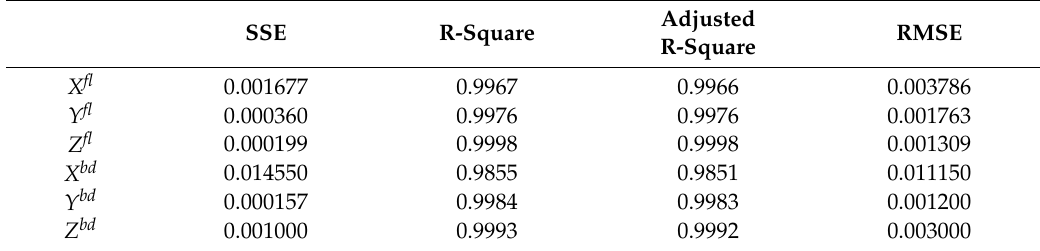
Table 2. Indexes of fitting curve in sagittal and coronal